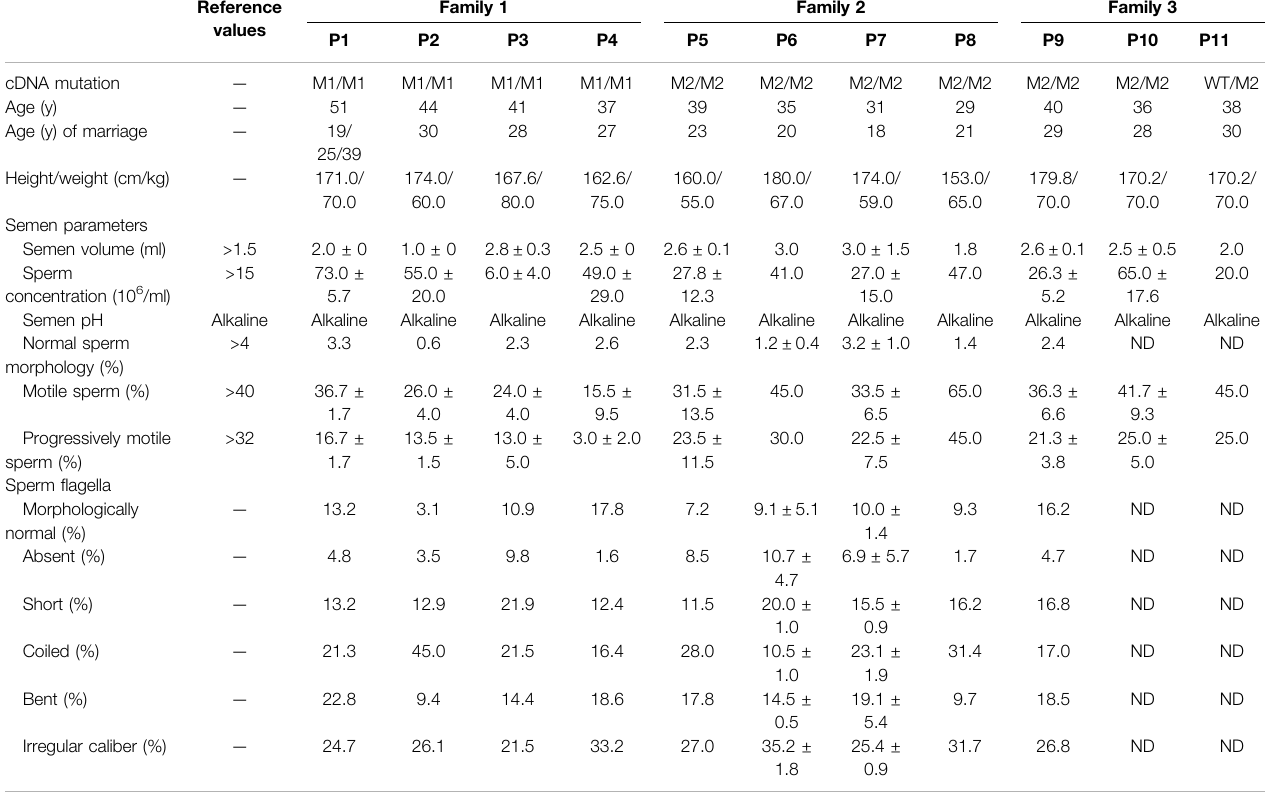
TABLE 1 | Clinical characteristics of